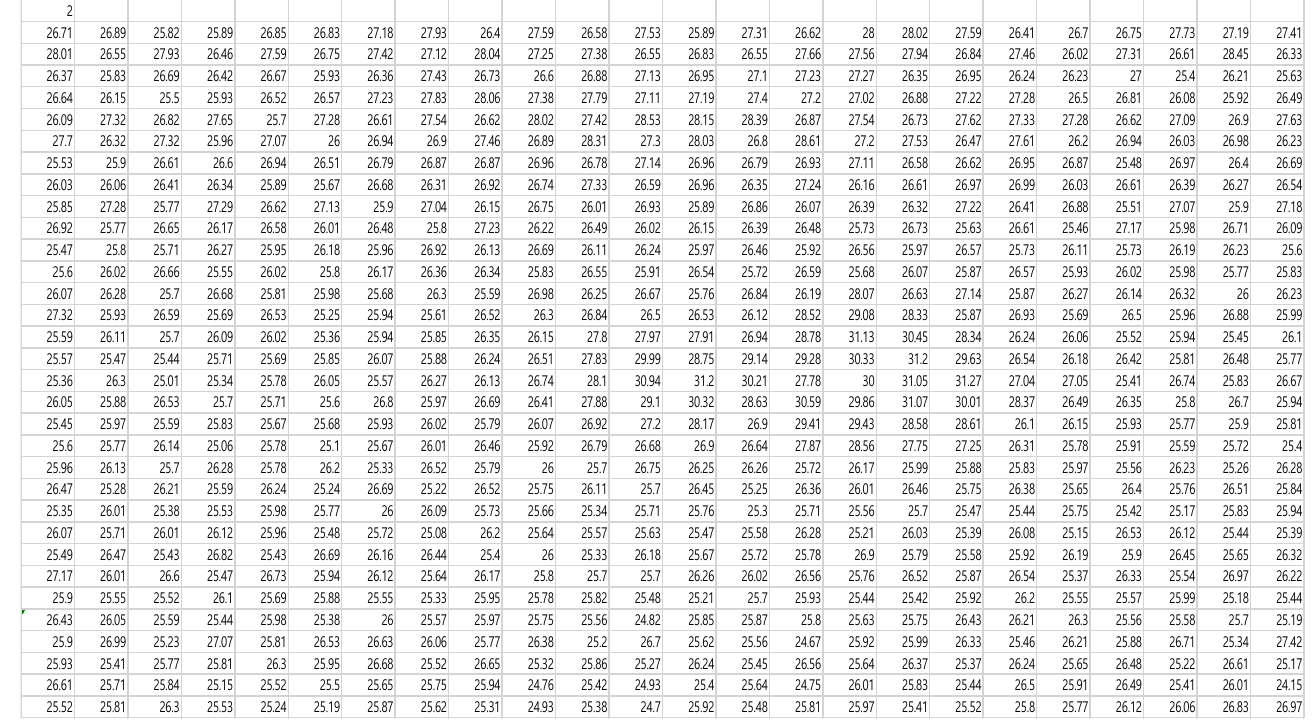
Figure 9. Surface temperature array data.